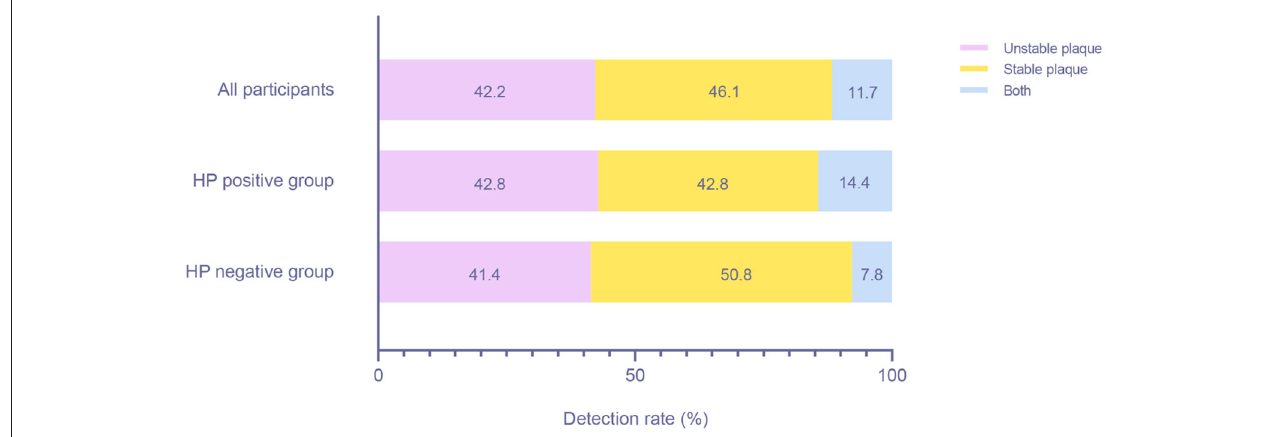
FIGURE 6 | Detection rates of patients with different plaque types between the HP-positive and HP-negative groups. HP, Helicobacter pylori .